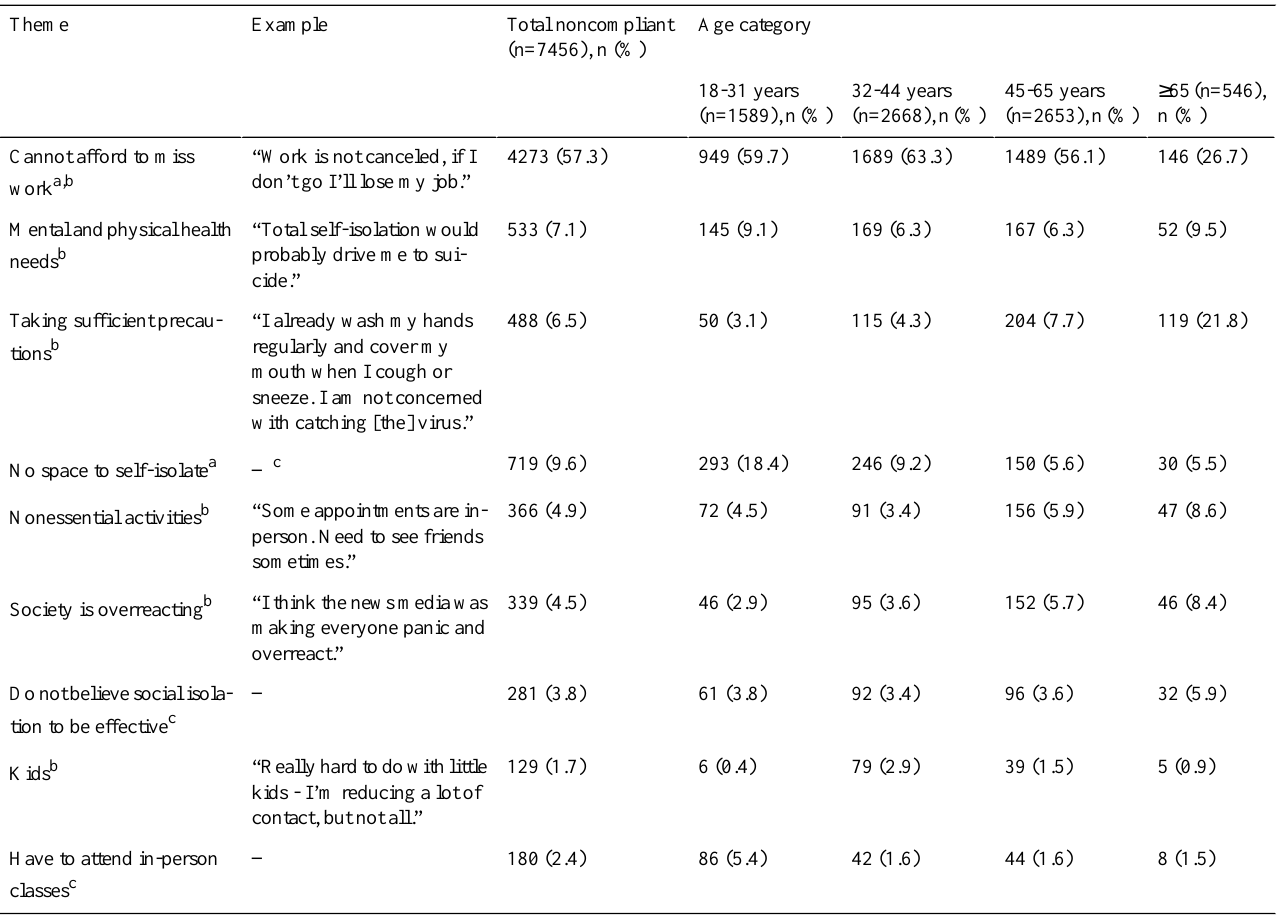
Table 2. Reasons for noncompliance with COVID-19 health orders by age group. Percentages were calculated as a proportion of noncompliant individuals in each age